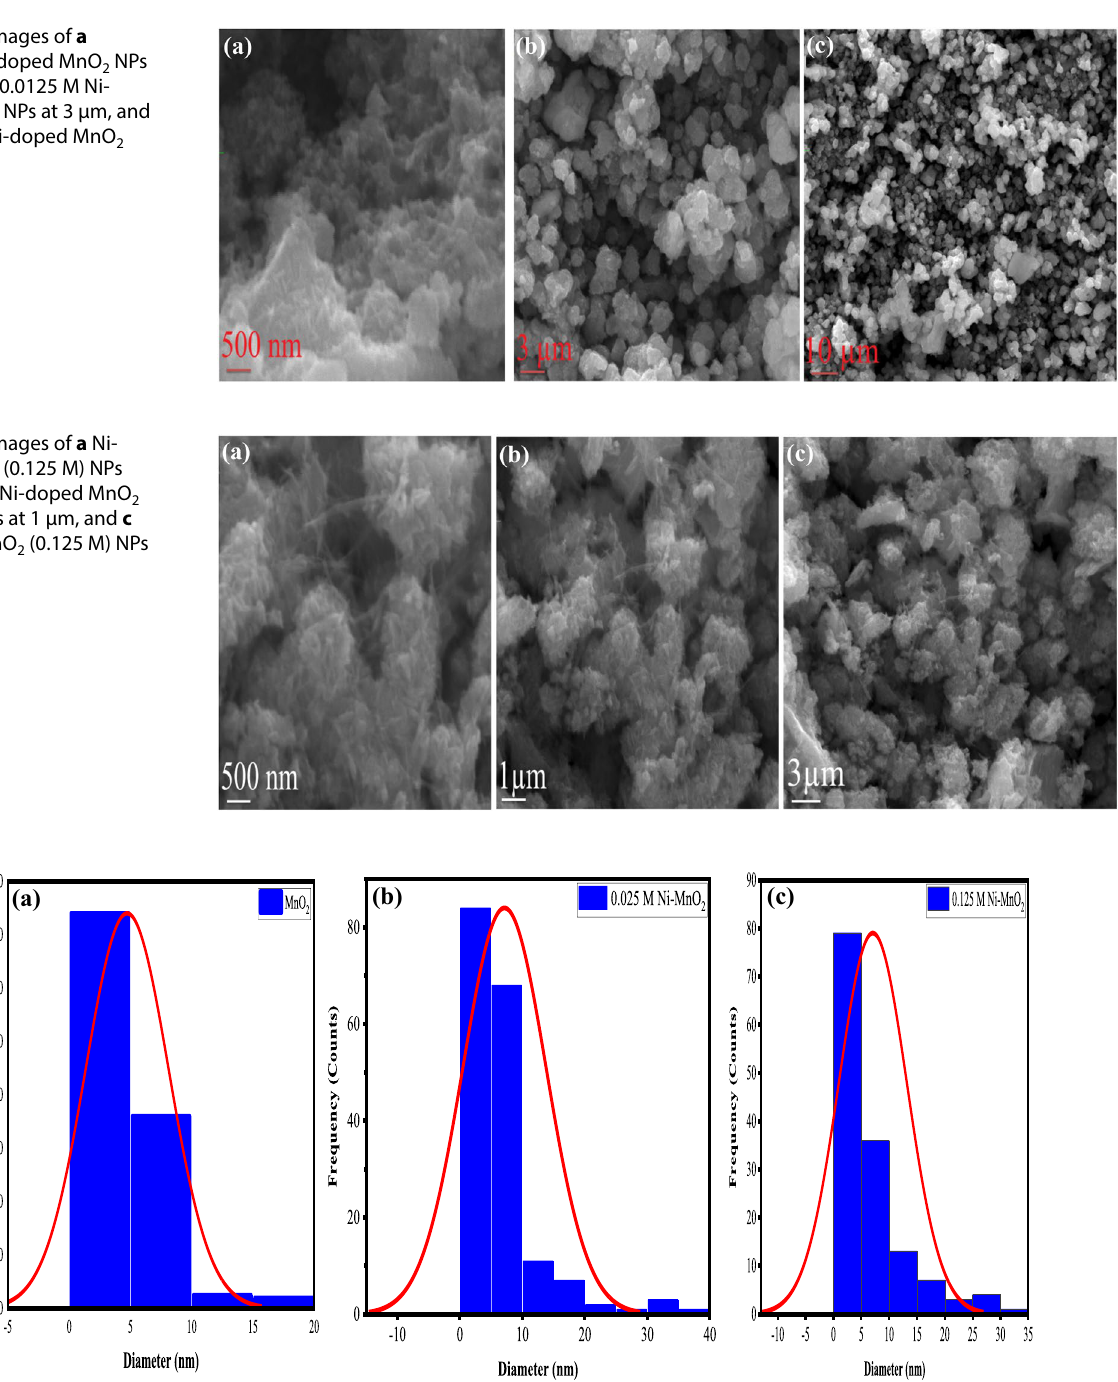
Fig. 7 Histogram scheme showing a particle size distribution of a MnO